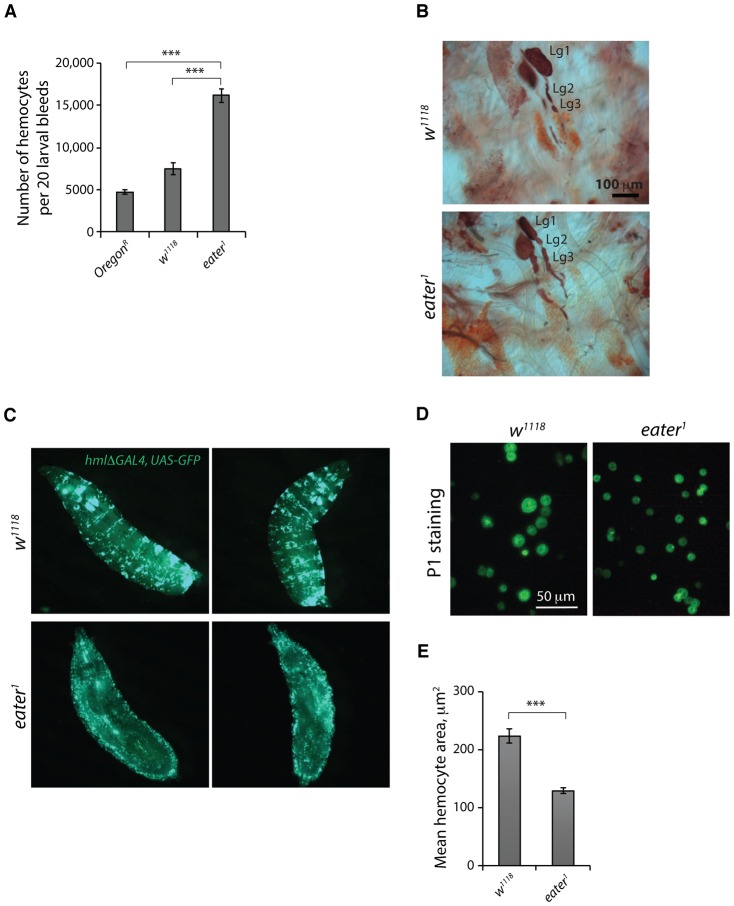
eater is required in plasmatocytes for binding of sub-epidermal body wall tissue.(A) Aggregated flow cytometry measurements from phagocytosis assays (Fig. 2A,B) of the number of hemocytes per 20 larval bleeds of Oregon R, w1118 and eater1 mutant larvae. OregonR, n = 41; w1118, n = 12; eater1 mutant, n = 37. (B) Lymph glands of w1118 and eater1 mutant third instar larvae dissected and stained in situ with anti-Hemese primary antibody and HRP-conjugated secondary antibody, developed with the chromogen AEC. Lymph gland primary, secondary and tertiary lobes are labeled Lg1, Lg2 and Lg3, respectively. (C) Live mount images of w1118 and eater1 third instar larvae expressing UAS-GFP in plasmatocytes driven by the HmlΔGAL4 transgene. (D) Fixed hemocytes from w1118 and eater1 larvae spread on HCl-cleaned glass slides, stained with the plasmatocyte-specific P1 antibody. (E) Mean cell areas of hemocytes from w1118 and eater1 larvae spread on HCl-cleaned glass slides.